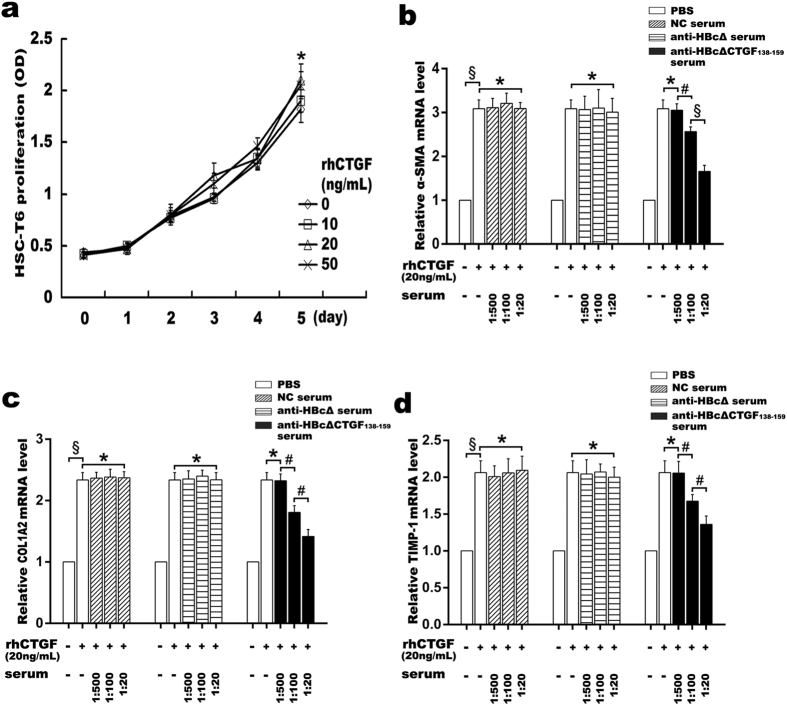
The anti-HBcΔCTGF138–159 serum suppressed rhCTGF-induced activation of HSC-T6 cells.rhCTGF up to a concentration of 50 ng/mL did not significantly affect the proliferation of HSC-T6 cells (a) (* vs , P > 0.05;  vs  or , P > 0.05). RQ-PCR evaluation of α-SMA (b), COL1A2 (c) and TIMP-1 (d) mRNAs indicated that the serum from HBcΔCTGF138–159-immunized mice dose-dependently abolished rhCTGF (20 ng/mL)-induced up-regulation of α-SMA, COL1A2 and TIMP-1 in HSC-T6 cells, while the serum from either HBcΔ-immunized or NC mice had no effect. *P > 0.05, #P < 0.05, §P < 0.005. Error bars indicate the SEM. α-SMA, α-smooth muscle actin; RQ-PCR, Real-time quantitative reverse transcriptase polymerase chain reaction; COL1A2, alpha 2 chains of collagen I; TIMP-1, tissue inhibitor of metalloproteinase-1; rhCTGF, recombinant human connective tissue growth factor.